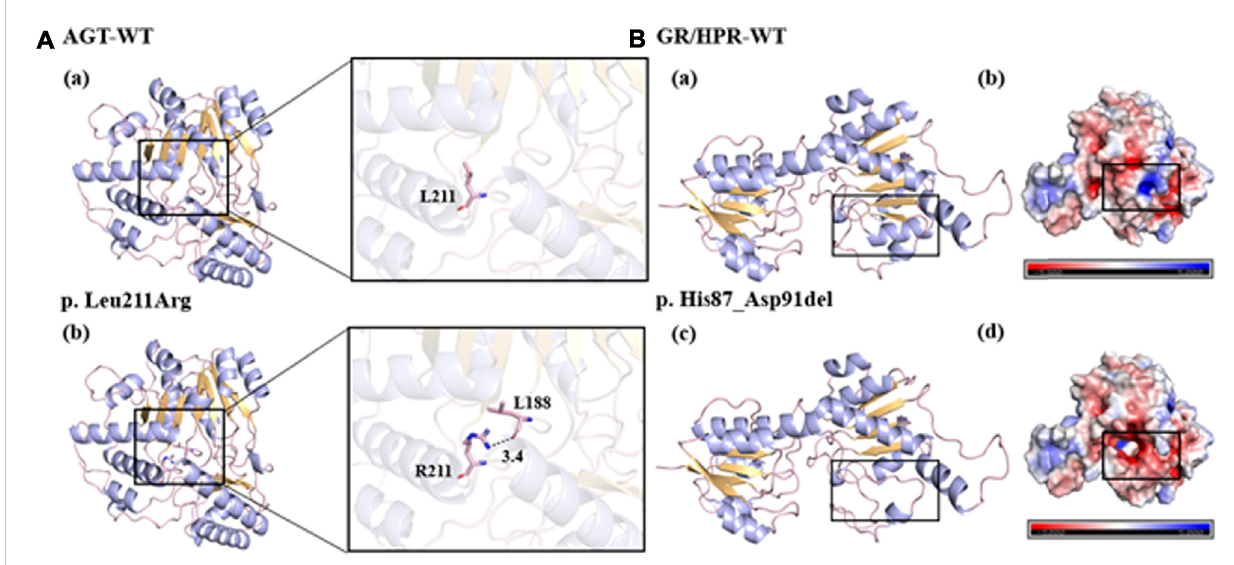
FIGURE 1 Predicted models of the novel variants. (A-a, b, B-a, c) : the bule line represented the target amino acid residue, the purple line represented the α helix,theyellowpartrepresentedthe β layer,andtheblackdottedlinerepresentedthehydrogenbond. (B-b,d) :bluerepresentedpositivepotential,white represented electrical neutrality, and red represented negative